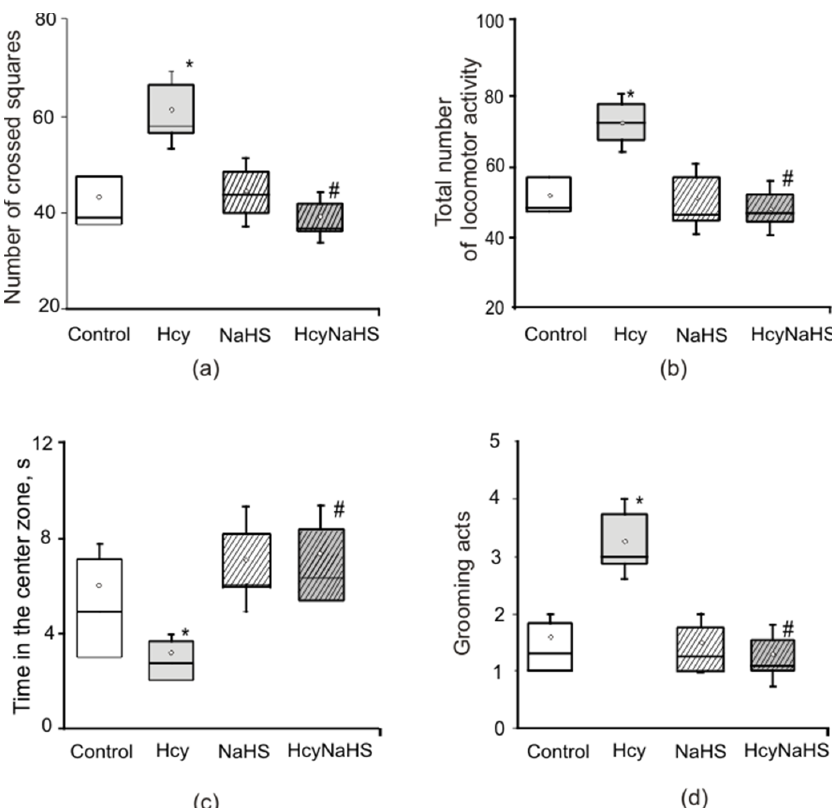
Figure 2. Effects of maternal hHcy and NaHS treatment on behavior in the open field test. Number of crossed squares ( a ), total locomotor activity ( b ), time spent in the central square ( c ), and grooming ( d ) of rats compared to control (white boxes), Hcy (grey boxes), NaHS (dashed boxes), HcyNaHS (grey dashed boxes) groups. * p < 0.05 compared to the control group, # p < 0.05 compared to the Hcy group.